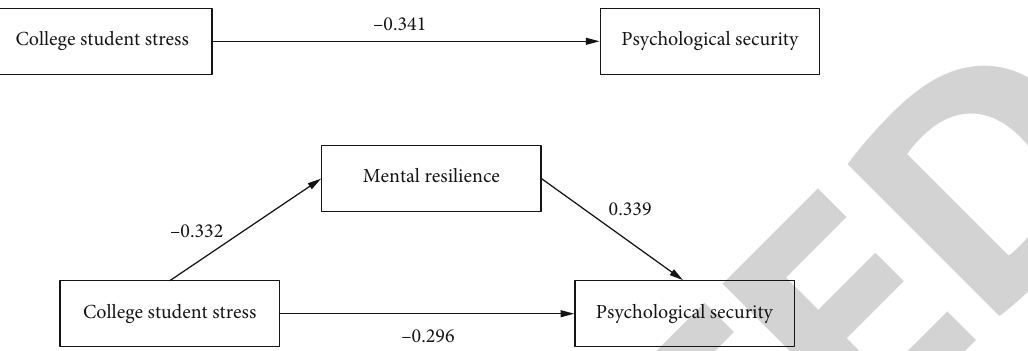
Figure 10: Path diagram of the mediating e ff ect of college students ’ stress, psychological resilience, and psychological security.